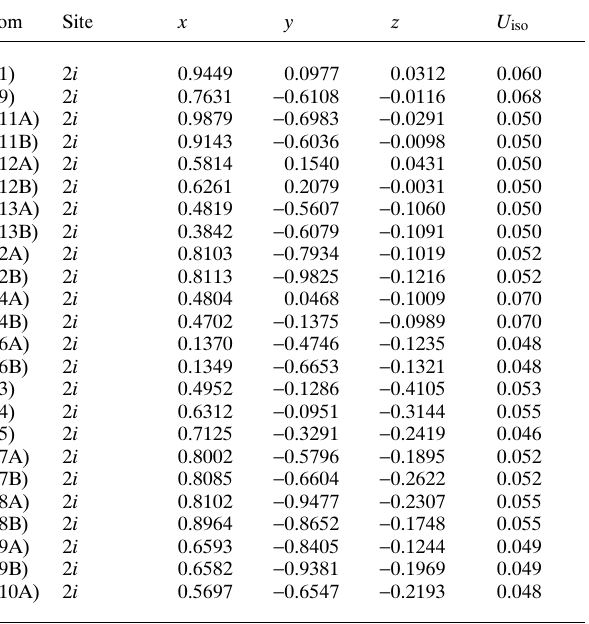
Table 2. Atomic coordinates and displacement parameters (in Å 2 ).